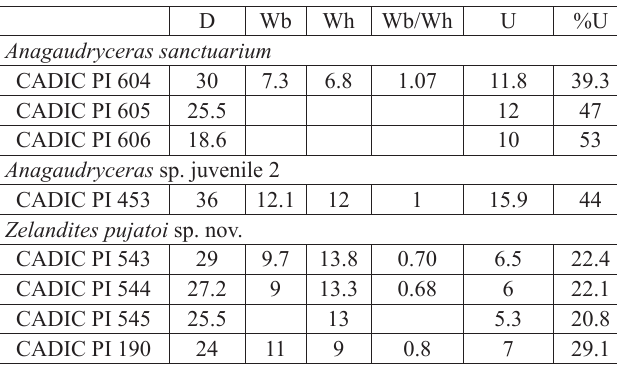
Type horizon : Early Campanian (Cretaceous), Member II, Rabot For- mation, Ammonite Assemblage 6 Natalites spp. Group 2.